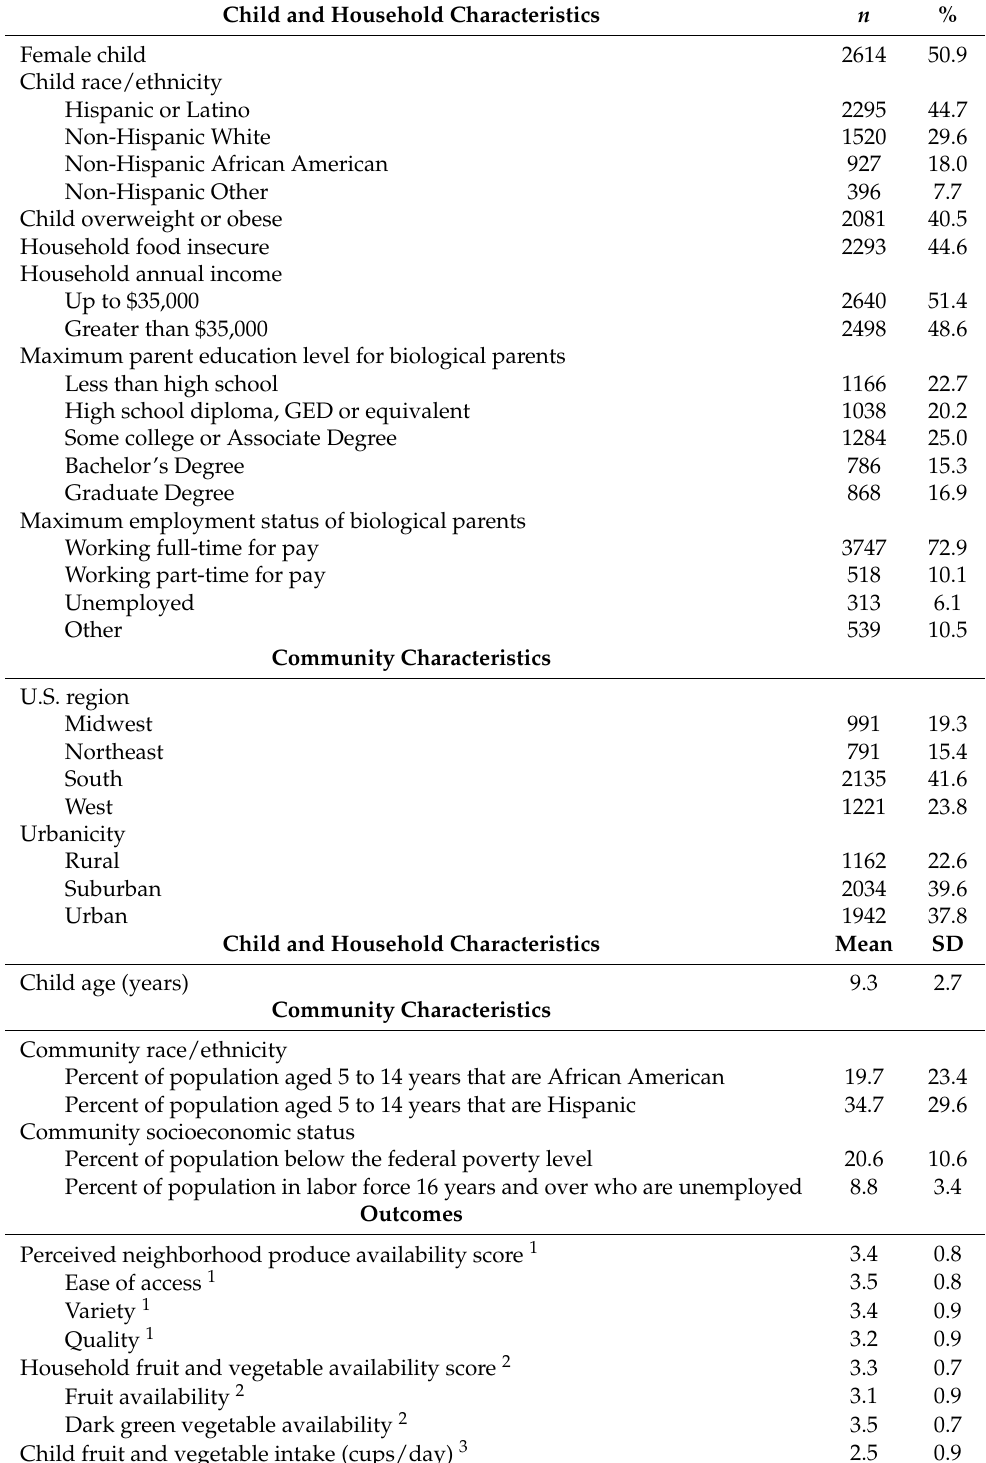
Table 1. Characteristics of children, households, and communities in the Healthy Communities Study (N = 5138 children, 130